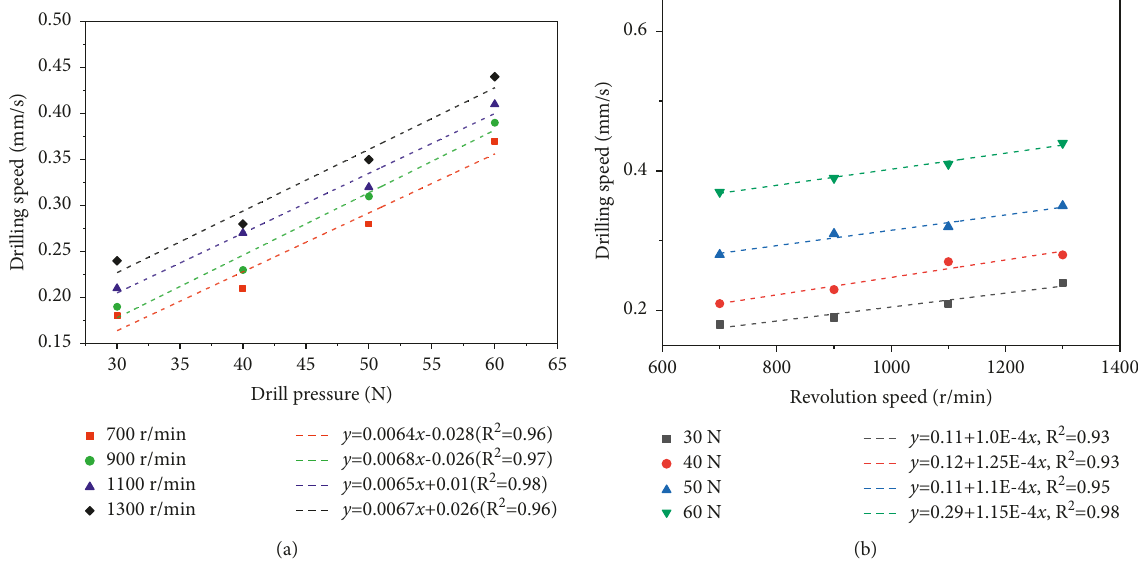
Figure 14: The variations of the DS with (a) the DP and (b) the RS of cyan